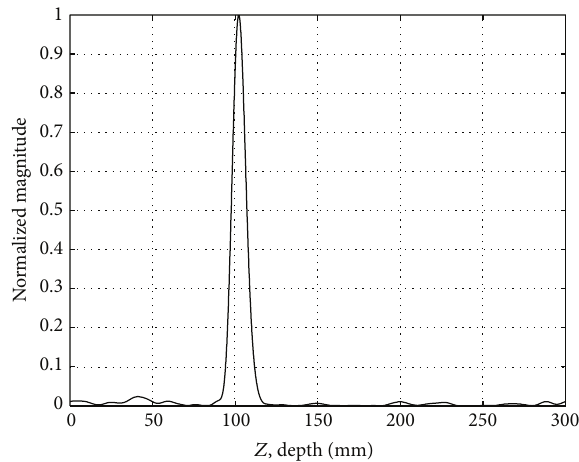
Figure 6: Calibrated received